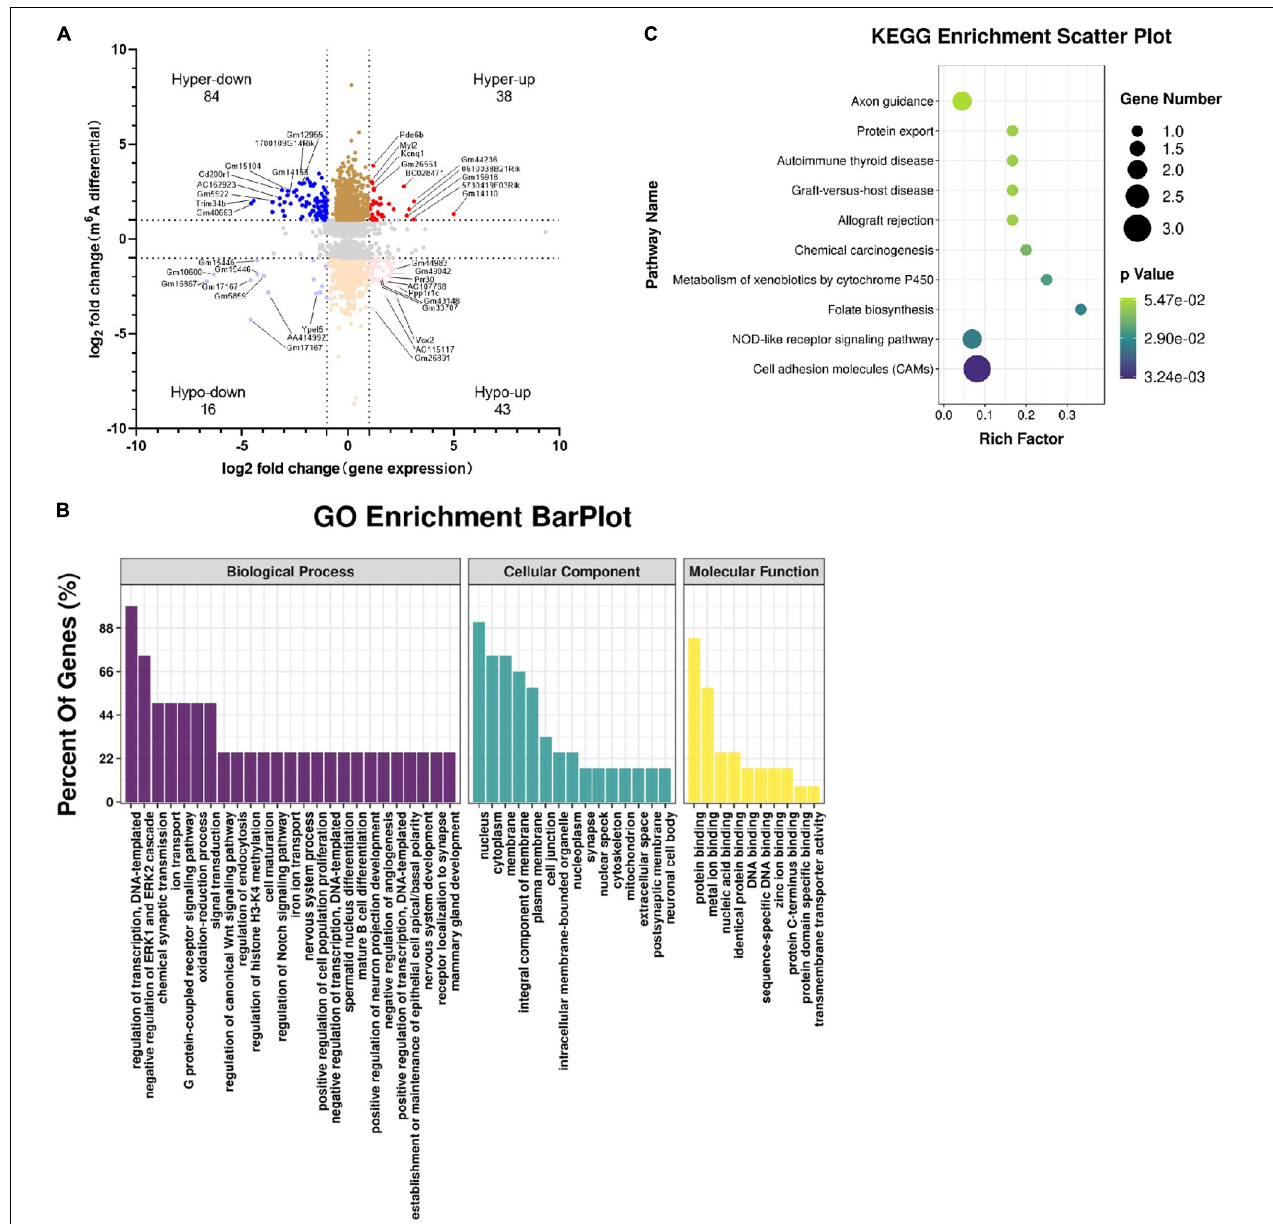
FIGURE 8 | Combined analyses of m6A-RIP-seq and RNA-seq data. Genes whose expression and m6A methylation differed significantly between Tyrobp − / − and wild-type mice were analyzed in terms of their (A) four-quadrant distribution (see Results), (B) major GO terms, and (C) top 10 KEGG pathways. Fold change ≥ 2 or fold change ≤ –2 and P < 0.05, nine mice were used in each